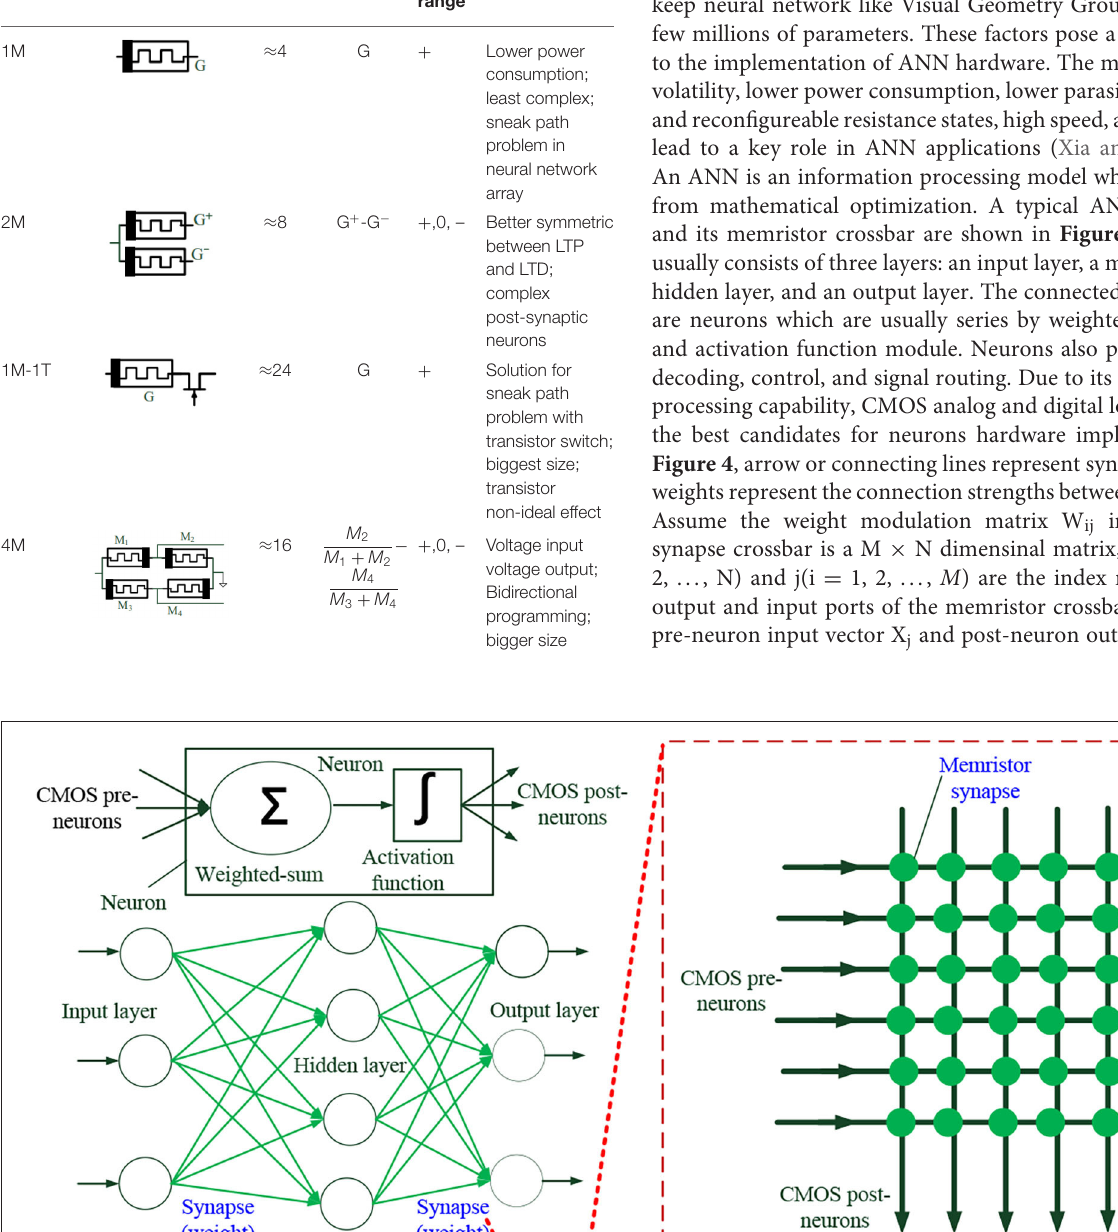
TABLE 2 | Comparison of different structure memristive synapse circuit. Synapses Structure